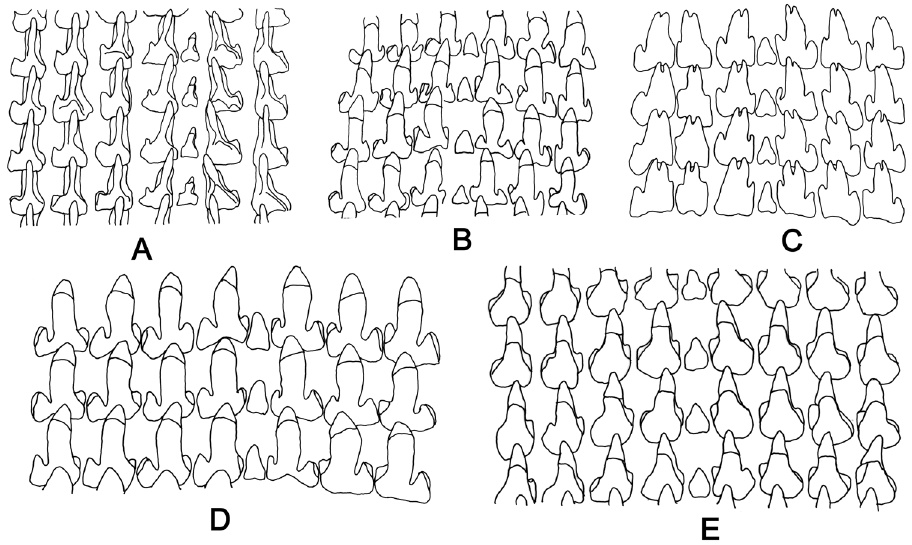
Figure 13. Radula of Glessula and Rishetia . A G. tamakoshi sp. n., CDZMTU057P, Suridobhan, Dolakha B R. kathmandica sp. n., CDZMTU062P, Godawari, Lalitpur C R. rishikeshi sp. n., CDZM- TUO70P, Jhawalepakho, Ridi, Gulmi D R. subulata sp. n., CDZMTU072P, Godawari, Lalitpur E R. nagarjunensis sp. n., CDZMTU067P, Raniban, Balaju,